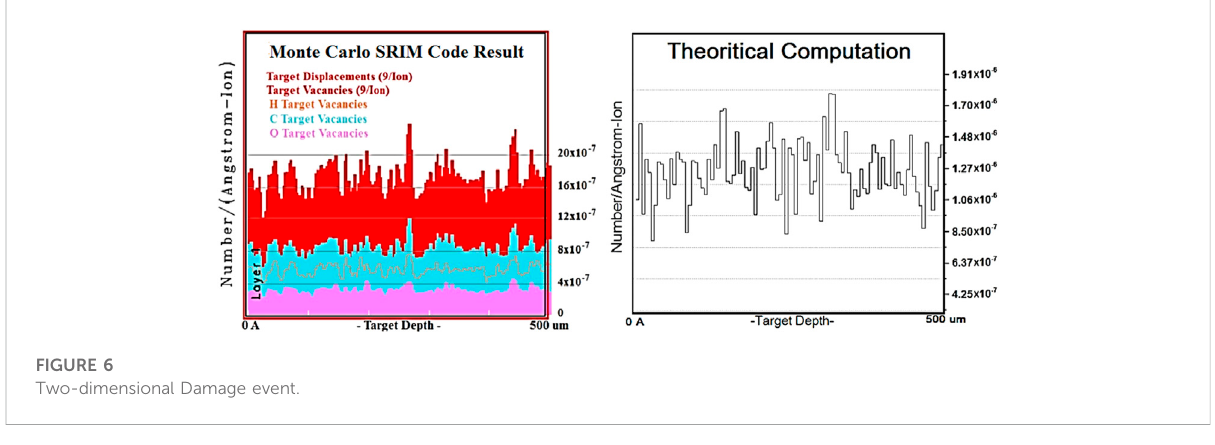
FIGURE 6 Two-dimensional Damage